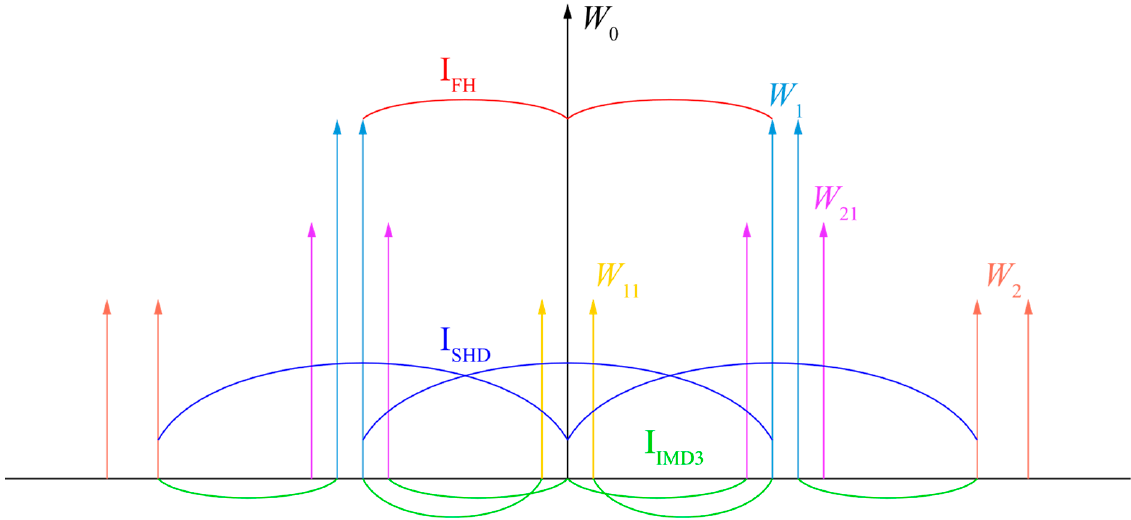
Figure A1. A schematic diagram of modulation sideband and photocurrent.